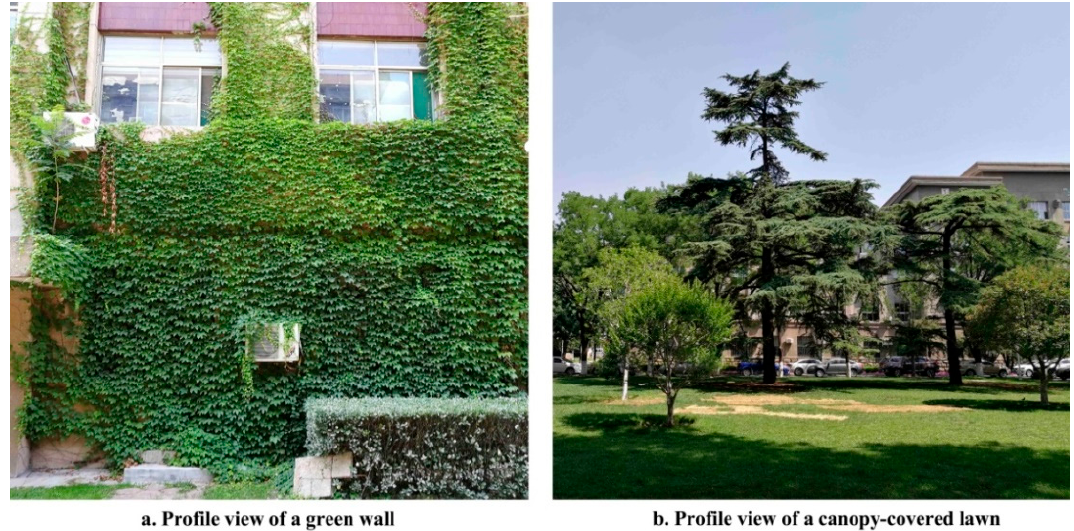
Figure 1. Profile view of a green wall ( a ) and a canopy-covered lawn ( b ).